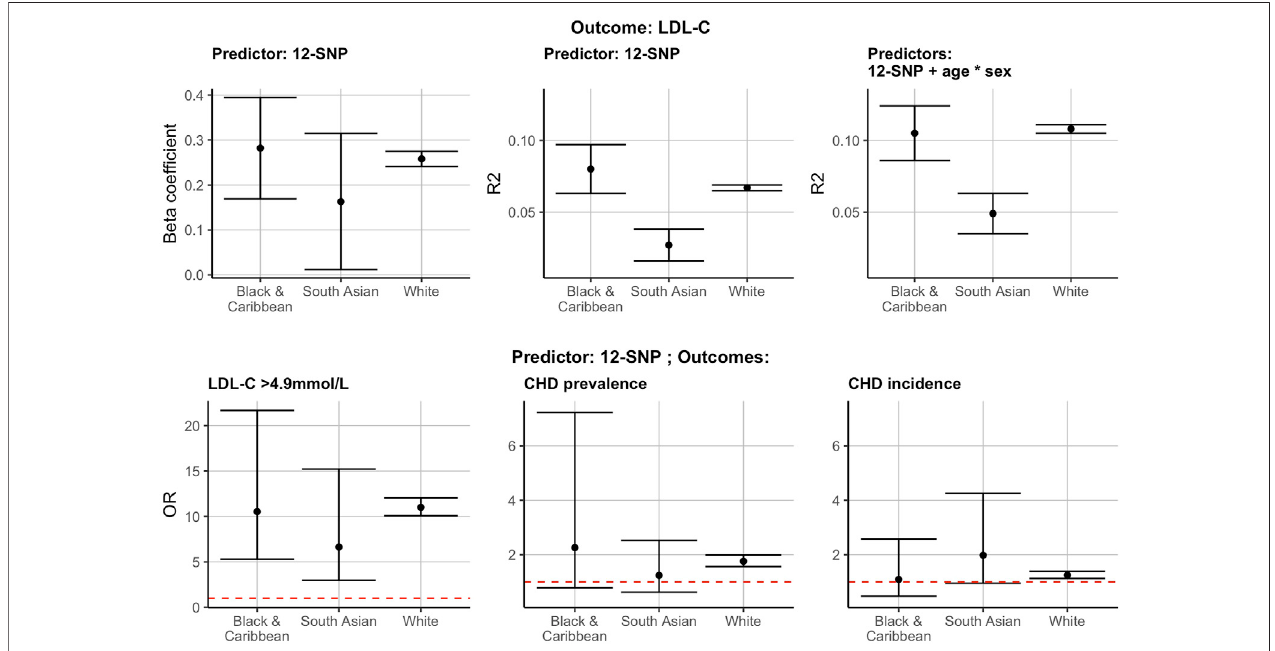
FIGURE2| The12-SNPscoreinthepredictionofLDL-C,hypercholesterolaemia(LDL-C > 4.9 mmol/L)andCHDprevalenceandincidenceinself-reportedBC,SA and WB ethnicities. The results presented here areusing the test data. *denotes the interaction term in theregression analysis. Thered dotted horizontal lines represent an OR of 1. CHD, coronary heart disease; LDL-C, low-density lipoprotein cholesterol; R2, correlation coef fi cient ( R 2 ); OR, odds ratio; BC, Black & Caribbean; SA, South Asian; WB, White British.